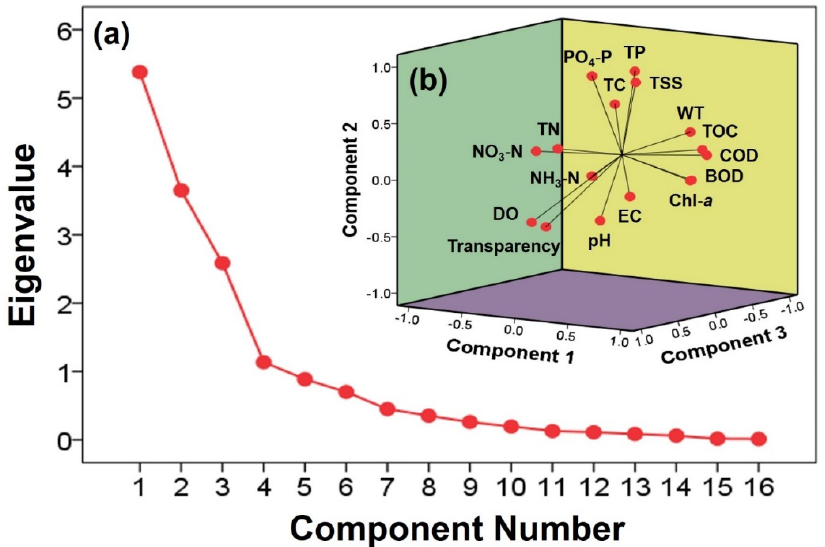
Figure 7. Principal component analysis of measured parameters by ( a ) screen plot of the characteristic roots (eigenvalues); ( b ) component plot in rotated space.